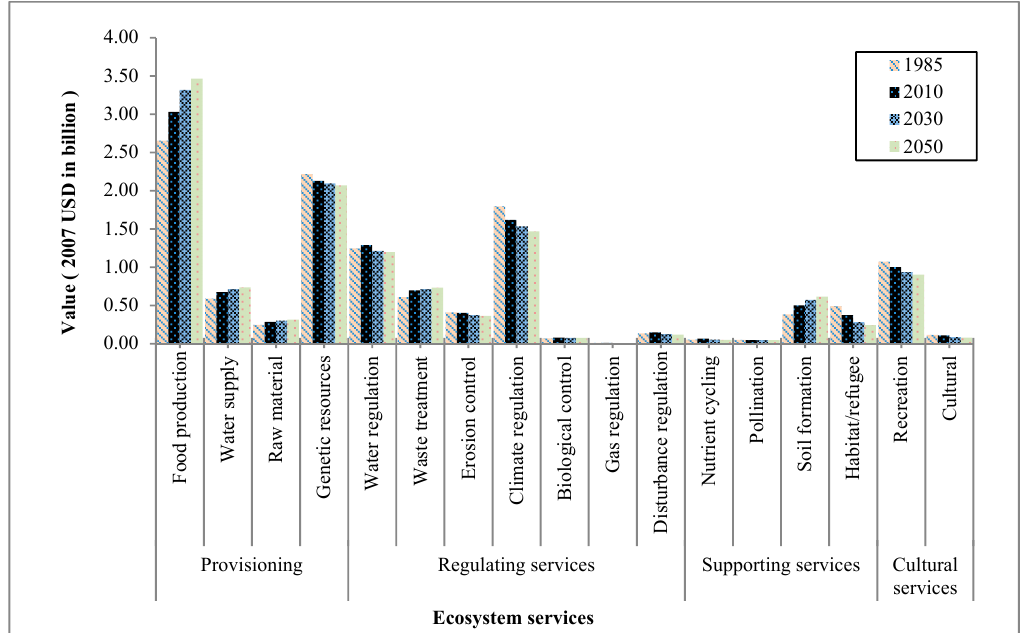
Figure 4. Effects of LULC change on the value of individual ecosystem services in ACB. Figure 4. E ff ects of LULC change on the value of individual ecosystem services in